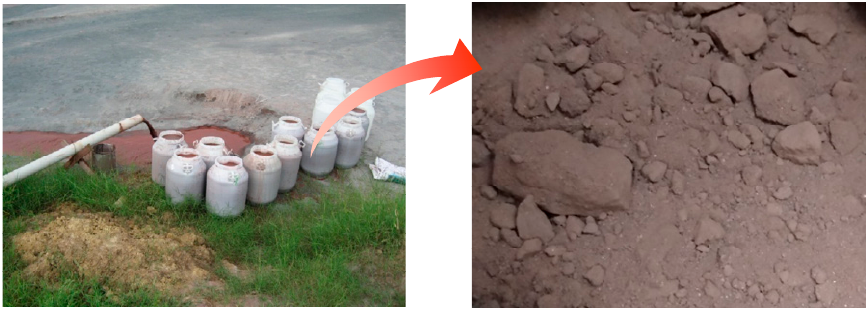
Figure 1. The full tailings, from the Lilou Iron Mine, used during CWRTB sample preparation. Table 1. Grain compositions of the full tailings material.